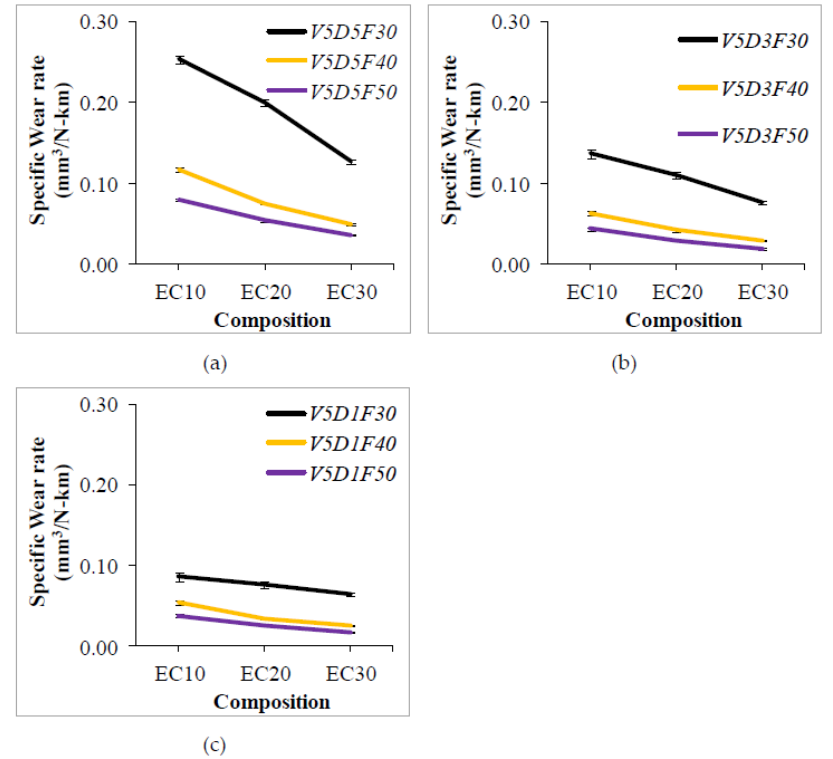
Figure 6. Experimentally measured specific wear rates at different sliding distances ( a ) 5 km ( b ) 3 km and ( c ) 1 km. 3 km and ( c ) 1 A decrease in the specific wear rate of all of the samples is seen with the increase in load. A substantial decrease is observed at EC-30, showing higher wear resistance at higher loads. A minimum specific wear rate of 0.02 mm 3 /N-km is observed with EC-30 in the V5D1F50 condition.